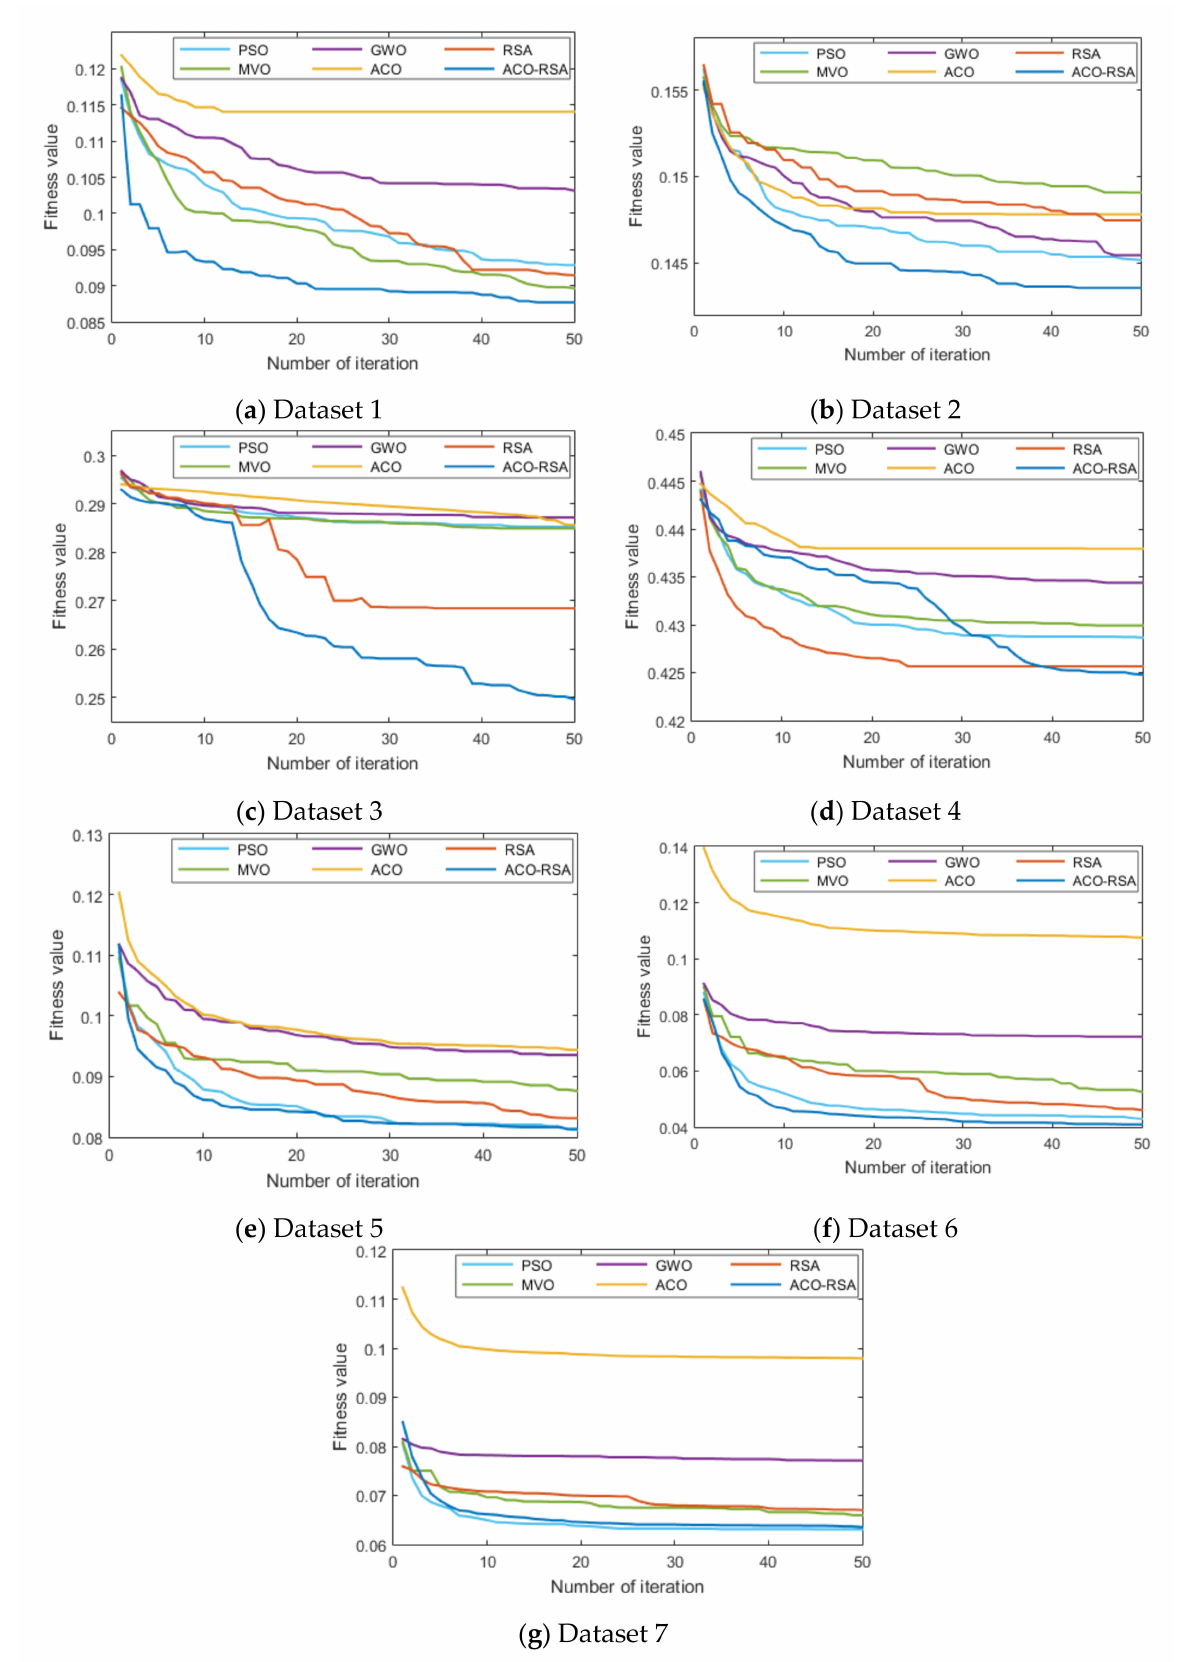
Figure 5. The convergence curves of the ACO-RSA and the other